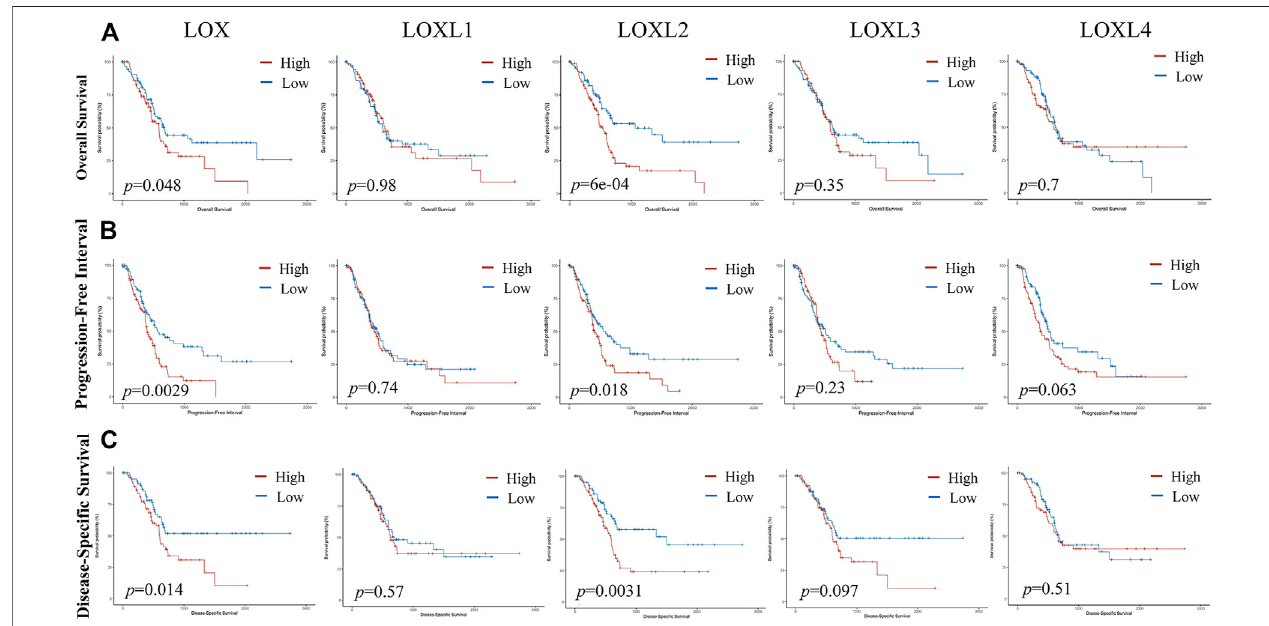
FIGURE 12 | The prognosis value of LOXs expression in PDAC. (A) Upregulated LOX and LOXL2 were highly correlated with poor overall survival (OS) in PDAC patients. (B) Upregulated LOX, LOXL2, and LOXL4 were signi fi cantly associated with inadequate progression-free interval (PFI). (C) LOX and LOXL2 expression was negatively related to disease-speci fi c survival